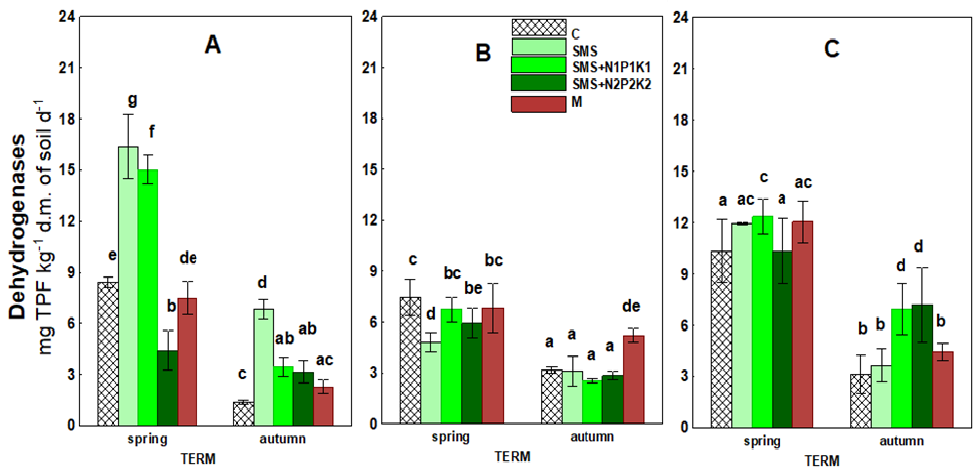
Figure 4. Activity of dehydrogenases in control soil and soil under different treatment strategies. ( A ) — 1st year; ( B ) — 2nd year; ( C ) — 3rd year. C — control soil; SMS — soil + spent mushroom sub- strate; SMS + N1P1K1 — soil + spent mushroom substrate + mineral fertilization N1P1K1; SMS + N2P2K2 — soil + spent mushroom substrate + mineral fertilization N2P2K2; M — soil + manure. The vertical lines indicate the standard deviation. Different letters above the columns indicate signifi- cant differences at p < 0.05, and each year was analyzed independent of each other.